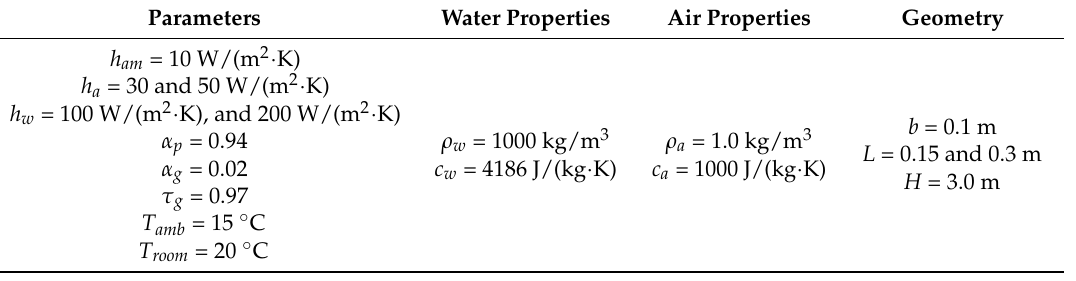
Table 1. Parameters of the modified Trombe wall